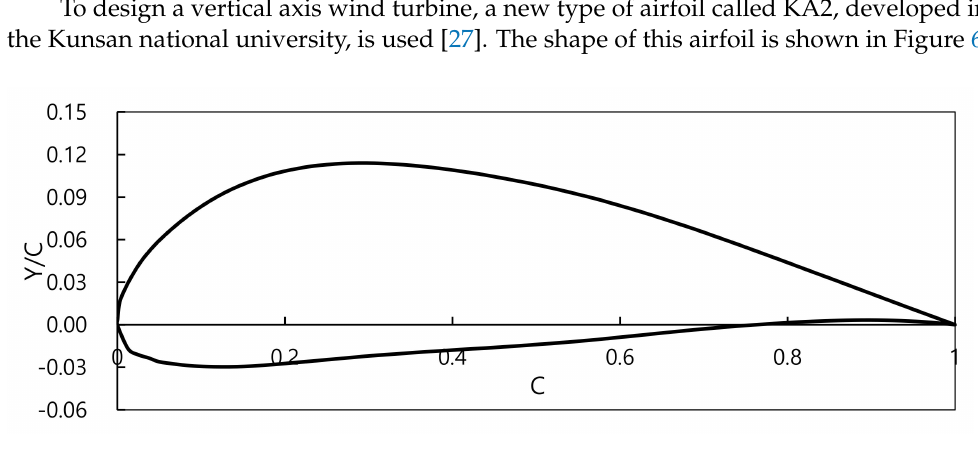
Figure 6. KA2 airfoil